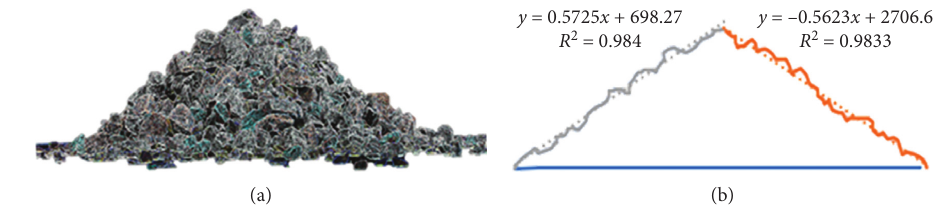
Figure 2: The measurement method of the angle of repose.